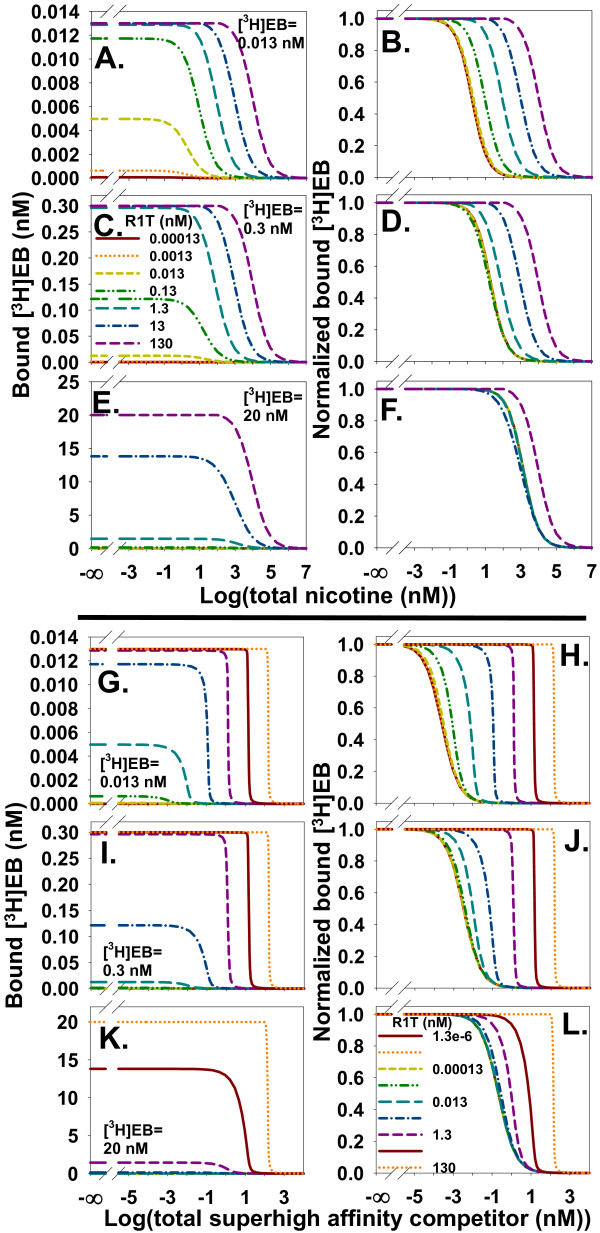
Effects of ligand depletion on heterologous competition data depend on the relative affinity of the inhibitor. A-F. Competition data for [3H]EB and nicotine were generated with two sites modelfree with [3H]EB = 0.013 (A & B), 0.3 (C & D), and 20 nM (E & F) and the R1T values shown in C. The y-axes of A, C, and E show total bound [3H]EB; y-axes of B, D, and F show normalized binding for comparing IC50 values. Data from small values of R1T are not distinguishable because of the ranges of the y-axis scales (A, C, and E) or because data sets overlap when rightward shifts of IC50 are negligible (B, D, and F). Ligand depletion shifts IC50 rightward; shape of the competition curve remains approximately sigmoidal. G-L. Competition data for [3H]EB and a hypothetical superhigh affinity competitor were generated with two sites modelfree with [3H]EB = 0.013 (G & H), 0.3 (I & J), and 20 nM (K & L) and the R1T values shown in L. The two inhibition constants Ki1 and Ki2 were 100-fold tighter (1.3 × 10-4 and 0.12 nM) than Kd1 and Kd2 for [3H]EB. Ligand depletion shifts IC50 rightward and increases the maximum steepness of the negative slope of the sigmoidal shape. Hill coefficients at R1T = 130 nM are -35, -35, and -17 for [3H]EB = 0.013, 0.3, and 20 nM.